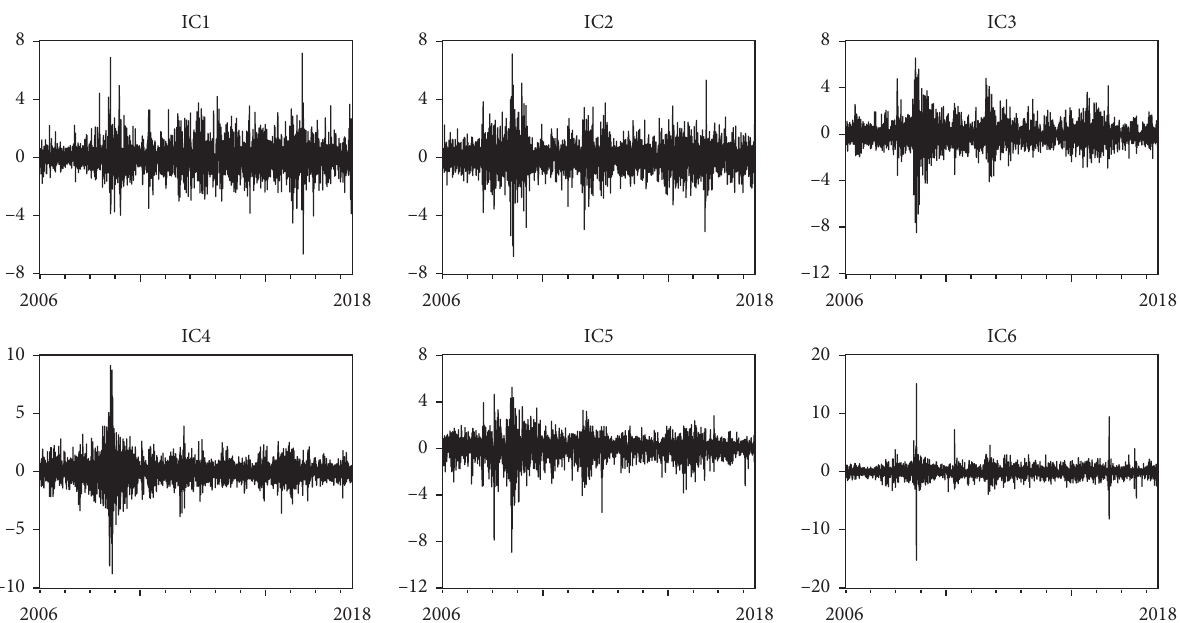
Figure 6: The time series of IC